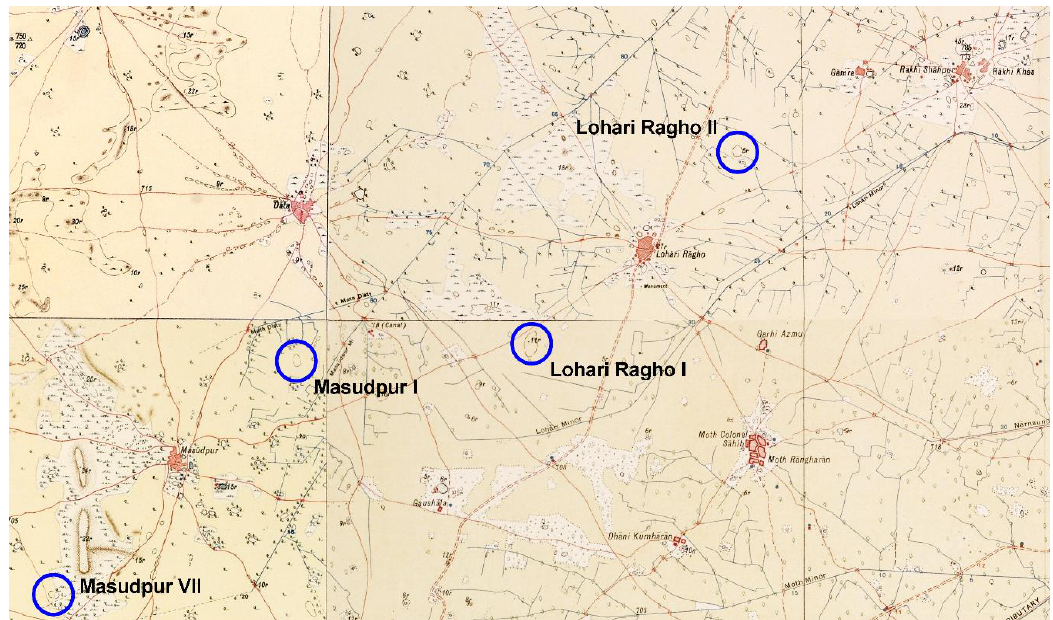
Figure 12. Four map sheets combined to show the area to the southwest of the Indus Civilisation urban site of Rakhigarhi (visible as a number of mounds under two modern villages at top right; also Figure 6), and the location of a selection of form-line mound features that correspond with surveyed archaeological sites (Base map image courtesy of Cambridge University Library).